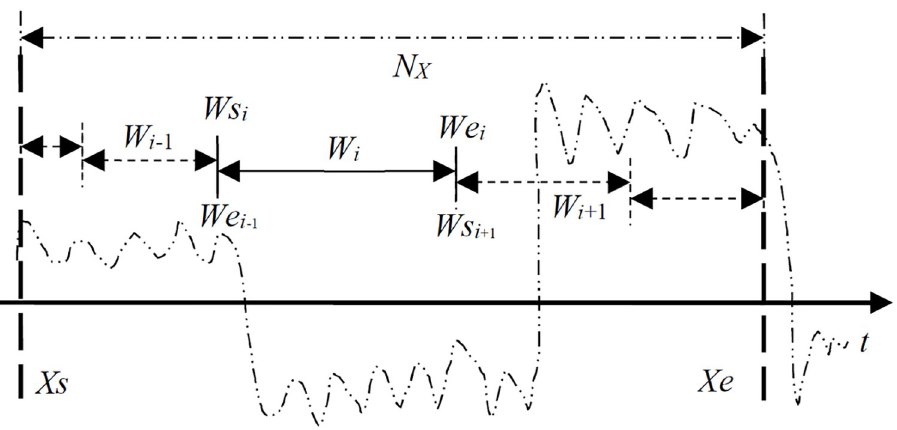
Fig 1. The scheme of the RSW approach for MCPs detection on time series sample X .